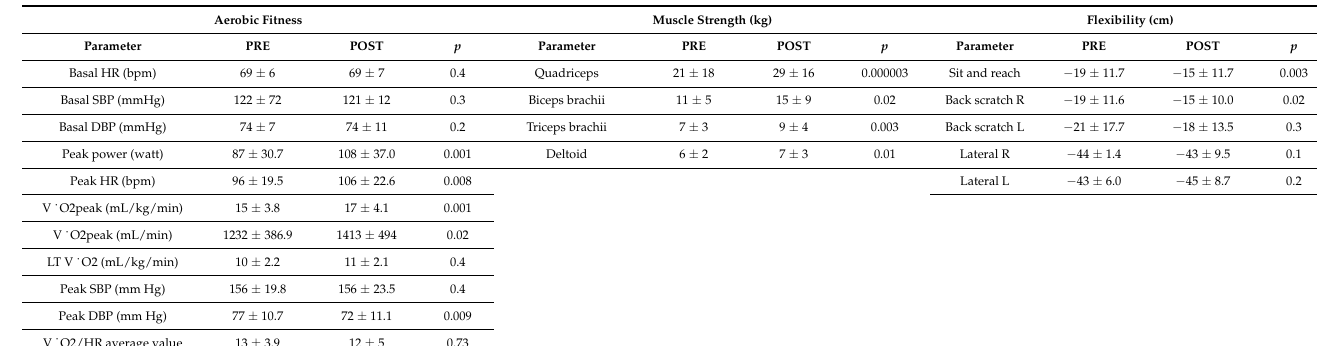
Table 2. Pre- and post-training data. HR, heart rate; SBP, systolic blood pressure; DBP, diastolic; R, right; L,